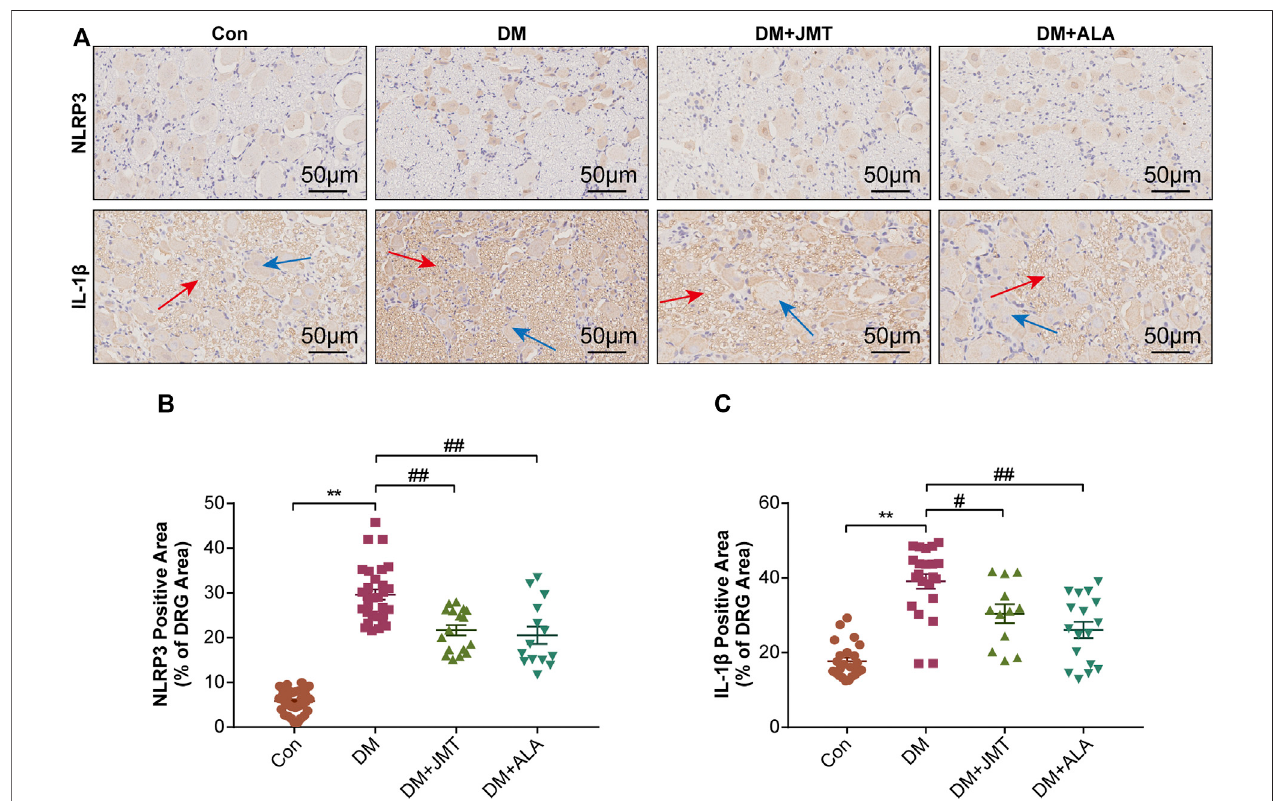
FIGURE 3 | Immunohistochemistry sections of DRG tissues in rats (A) Representative immunohistochemical images of NLRP3 and IL-1 β in different groups (magni fi cation, × 400; scale bars: 50 μ m). Quantitative analysis using immunohistochemistry images of (B) NLRP3 and (C) IL-1 β positive-stained area relative to total tissue area. The data are presented as mean ± SEM (n (cid:1) 6 per group). ** p < 0.01 vs Con group, # p < 0.05 vs DM group, ## p < 0.01 vs DM group. Con, control; DM, diabetes mellitus; ALA, alpha-lipoic